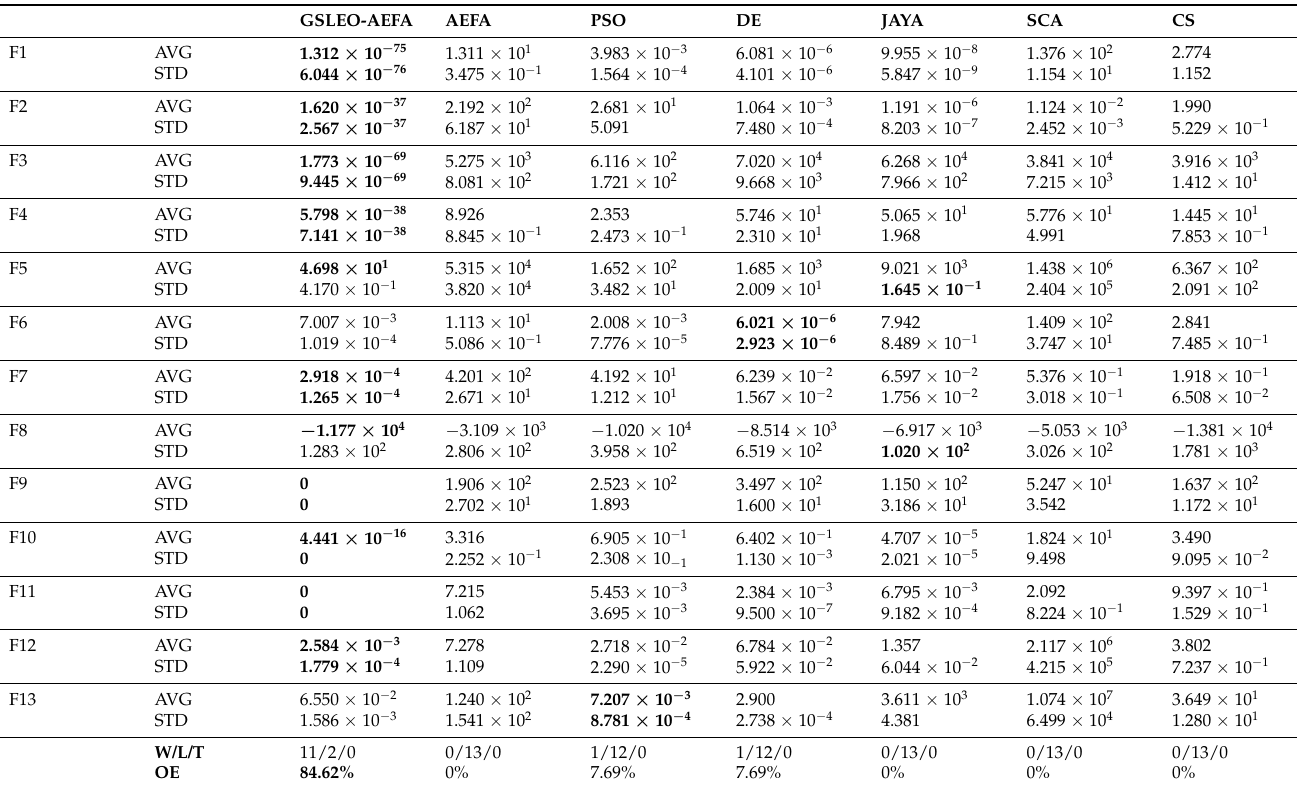
Table 4. F1–F13 Comparison with dimension = 50, significant values are in